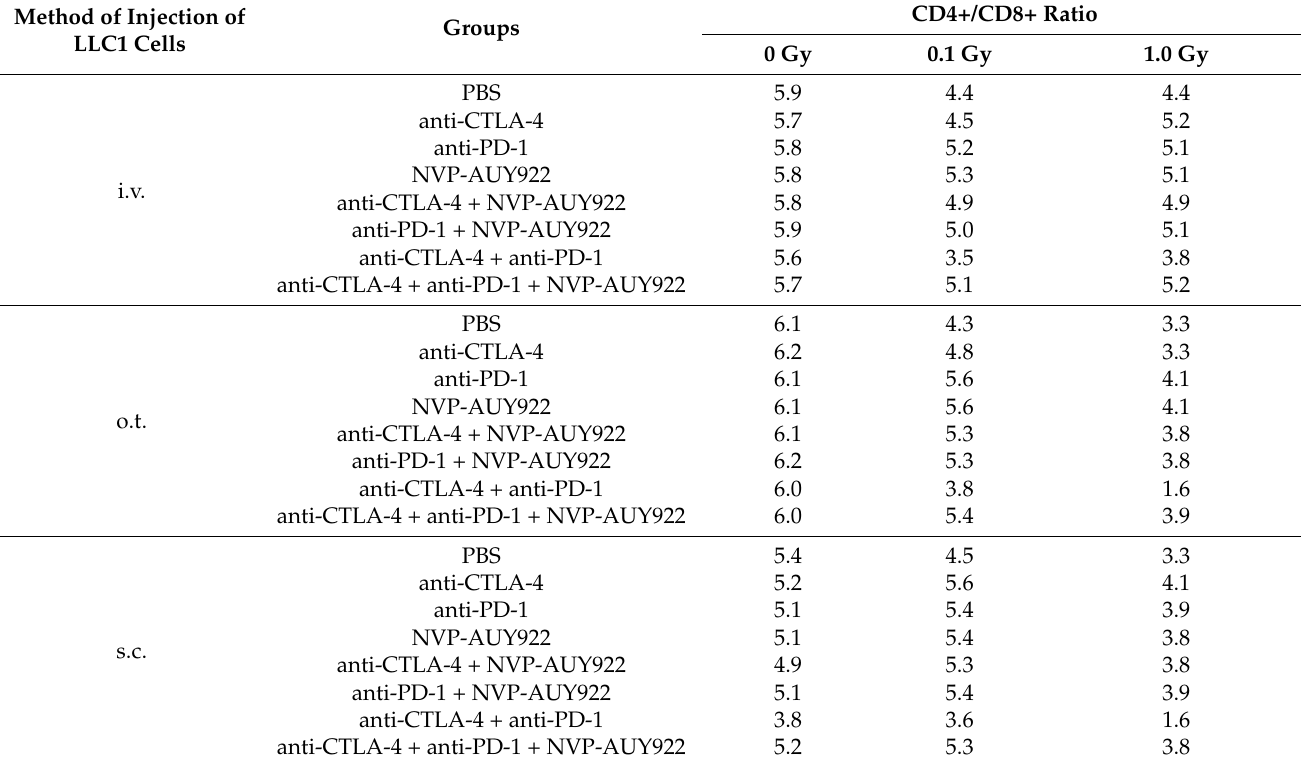
Table 3. The CD4+/CD8+ T lymphocyte ratios among the cells obtained from the lungs after i.v. or o.t. injection of LLC1 cells or from tumors grown subcutaneously in C57BL/6 mice treated with blockers of the immune checkpoints and/or HSP90 combined with WBI at total doses of 0.1 and 1.0 Gy. Method of Injection